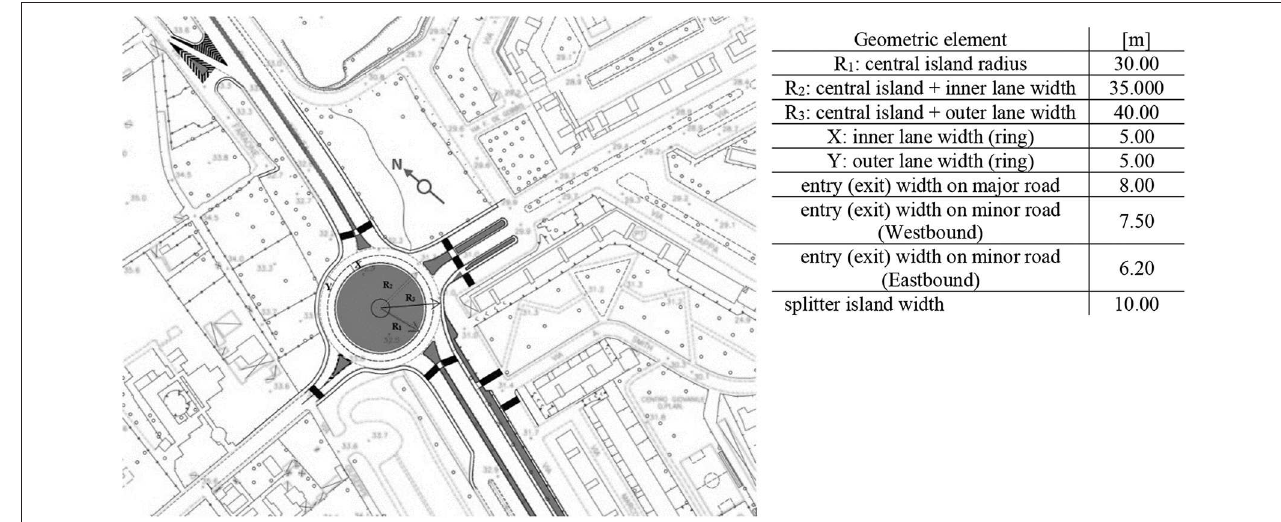
FIGURE 1 | Summary of the main geometric features of the examined roundabout (roundabout